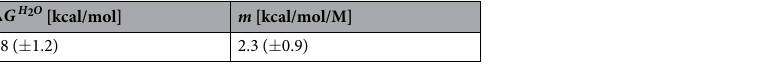
Table 3. Fit parameters from fitting the unfolding curve (Fig. 4) to the linear extrapolation model (equation (3)). The fit was performed on the averaged unfolding curve. The errors denote the standard errors of the fit